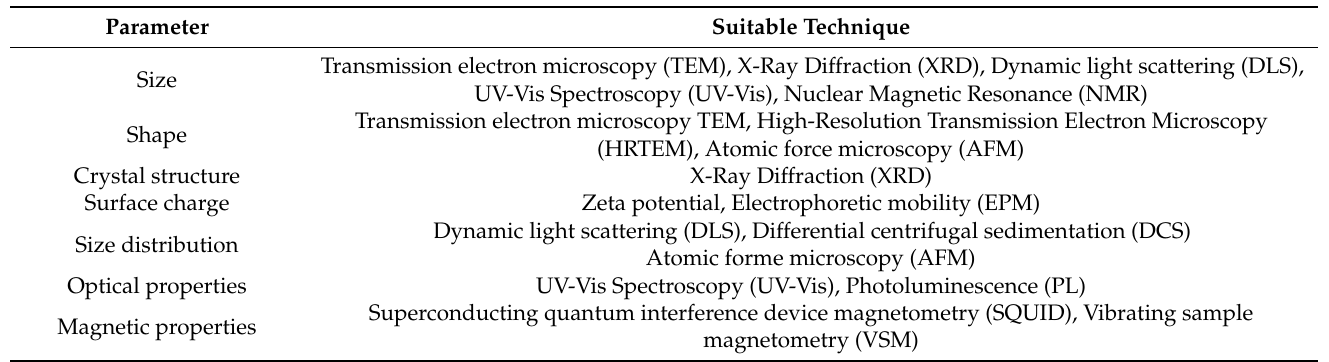
Table 2. Nanoparticle characterization